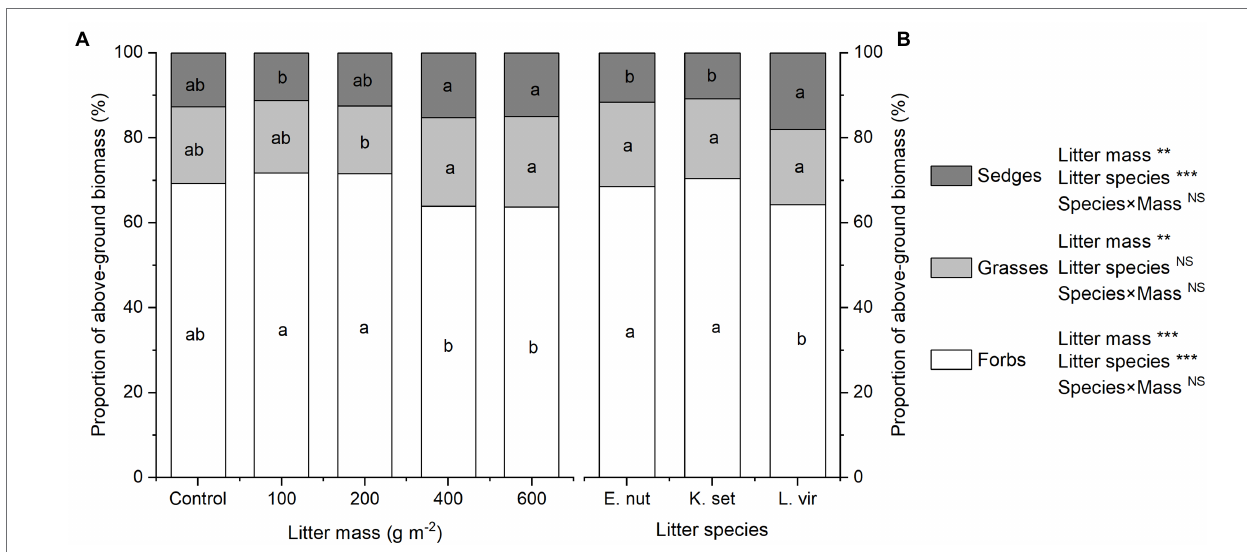
FIGURE 3 | Effects of litter mass (A) and species (B) on plant functional composition. Summarized into proportion of above-ground biomass of forbs, grasses, and sedges. Lowercase letters indicate significant differences at p < 0.05 (** p < 0.01 and *** p < 0.001; NS, not significant). E. nut , E. nutans ; K. set , K. setchwanensis ; L. vir , L. virgaurea .